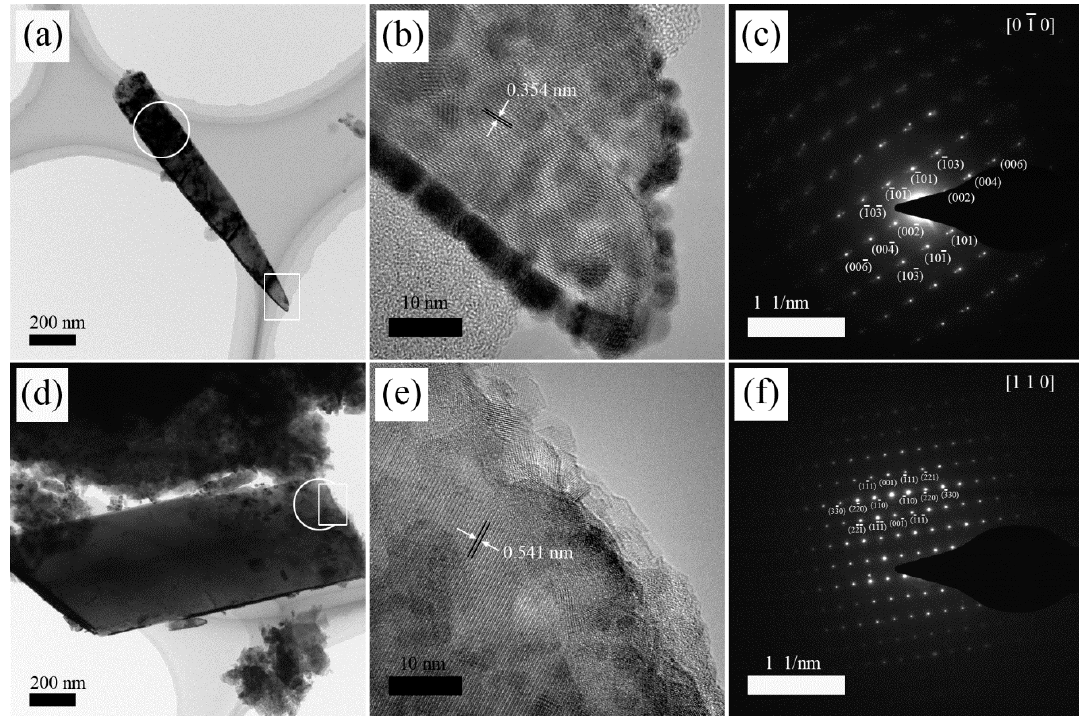
Figure 6. Transmission electron microscope (TEM) images and selected area electron diffraction (SAED) patterns of acicular TiO 2 ( a – c ) and hydroxyapatite (HAp) ( d – f ) particles formed on MAO/HT-treated Ti-5Zr. (The 1/nm unit means that the distance is in reciprocal lattice.).